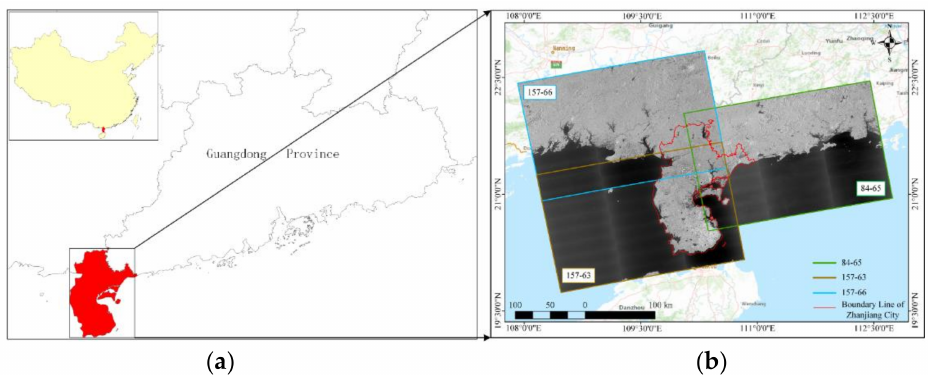
Figure 1. ( a ) Geographical location of the study area, ( b ) the Sentinel-1A data in the test